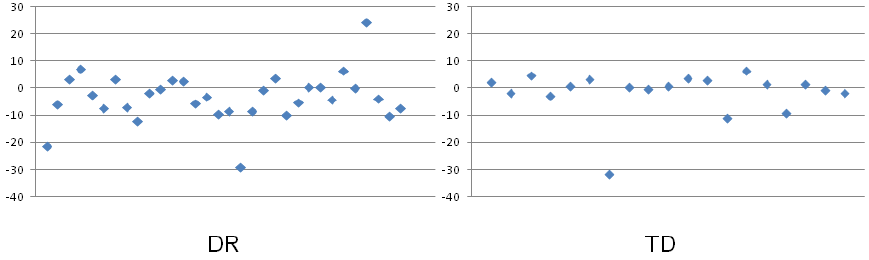
Figure 5. Scatter plots showing the mean EEs for all numbers used in the 0 – 100 verbal task calcu- lated for each participant. The results obtained in the DR group are presented on the ( left ) and the results obtained in the TD group are on the ( right ) .